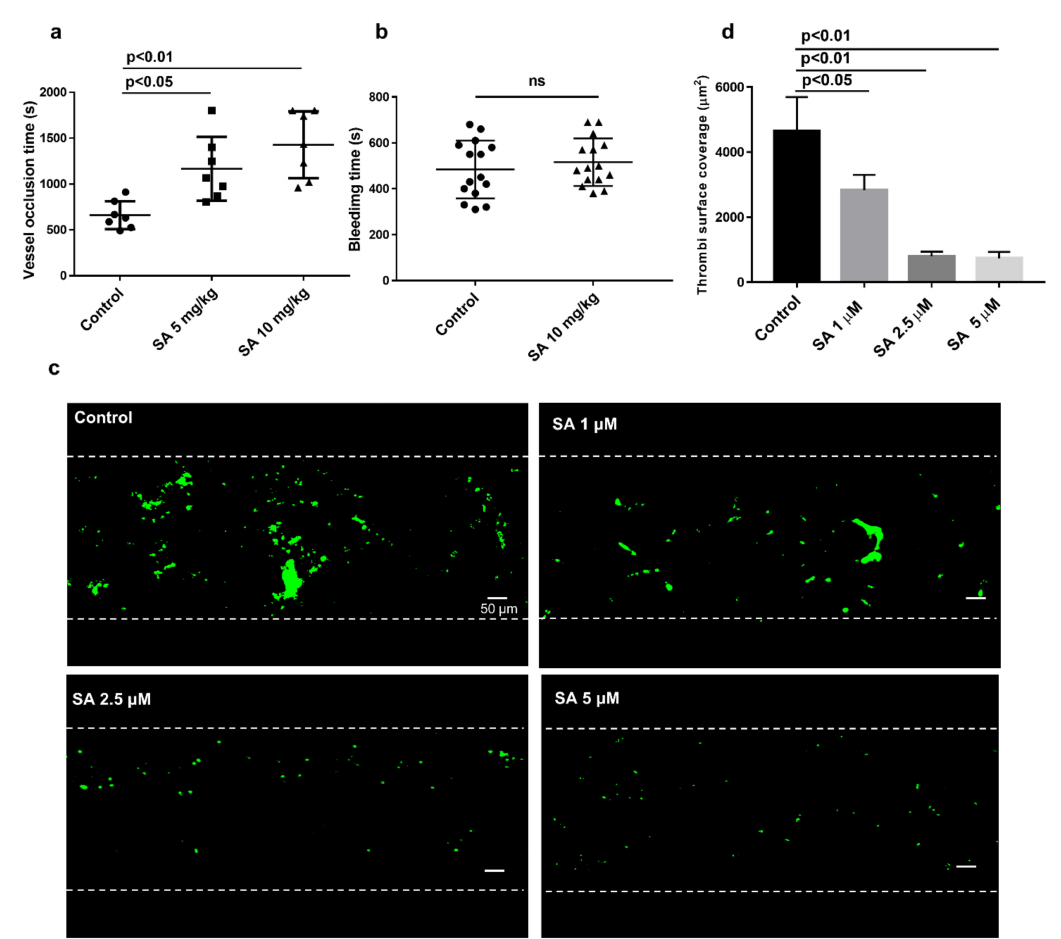
Figure 2. Sanguinarine inhibits the formation of thrombus in vivo and in vitro without prolonging bleeding time. ( a ) Summary data of ferric chloride (FeCl 3 )-induced thrombus formation. Thrombus formation in vivo was assessed by